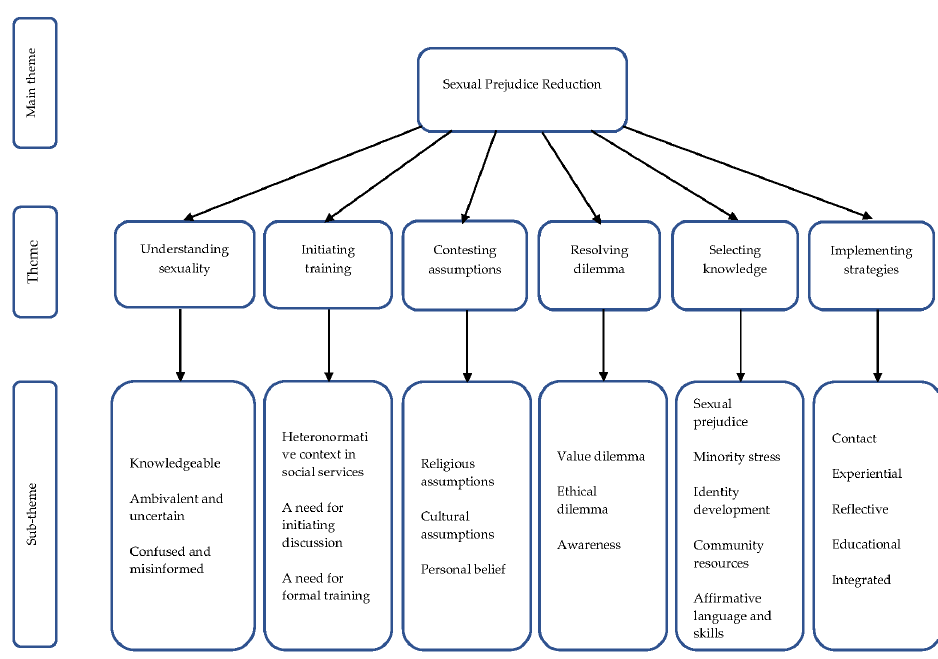
Figure 1. Quotes from informants’